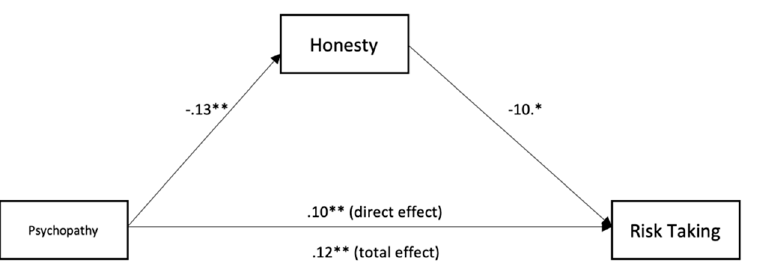
Figure 3. Mediation analysis for the relationship between Machiavellianism, courage, and risk-taking. ** p < 0.01.